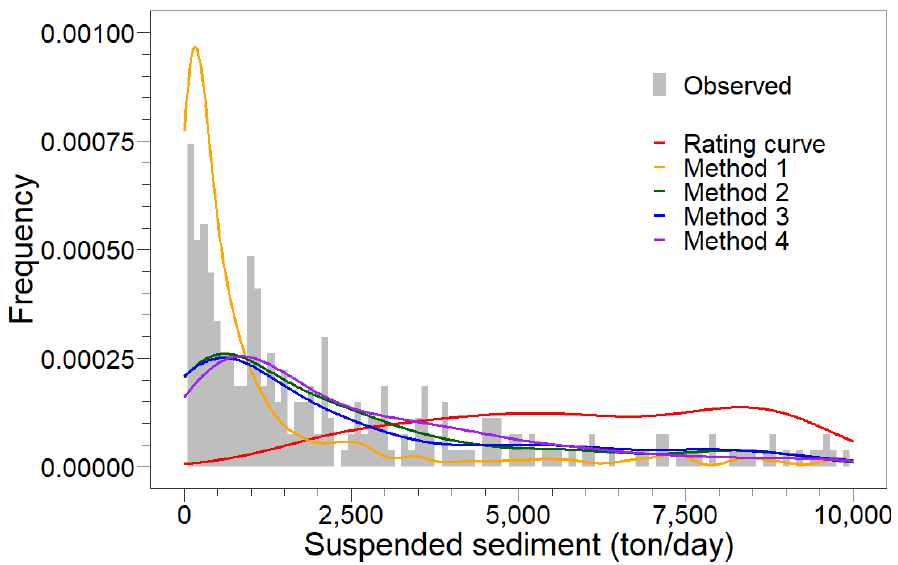
Figure 5. The frequency histograms of suspended sediment load of observed data associated with results of various infilling methods for the period of